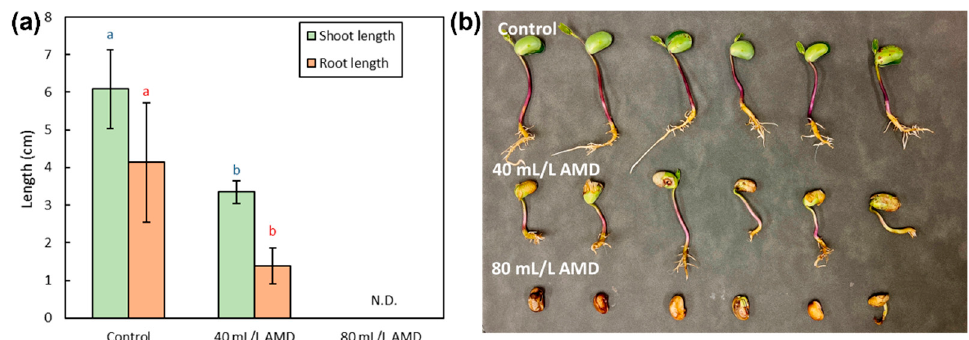
Figure 5. ( a ) Shoot and root length of soybean seedlings after 7 days. ( b ) Photo of soybeans after 7 days. (Different letters, a, b, and c, represent statistical differences between treatments; the error bar represents the standard deviation; Fisher LSD multiple comparison; p < 0.05 level; N ＝ 6).